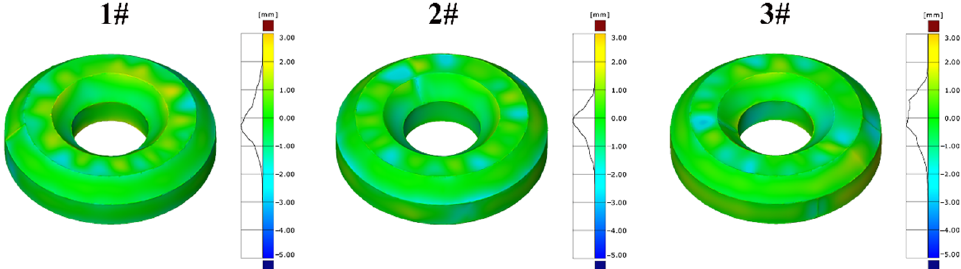
Figure 13. Geometrical deviations of preformed toroids from nominal geometry of black lines in Figure 1. Table 4. Measured wall thicknesses of three preformed toroids.